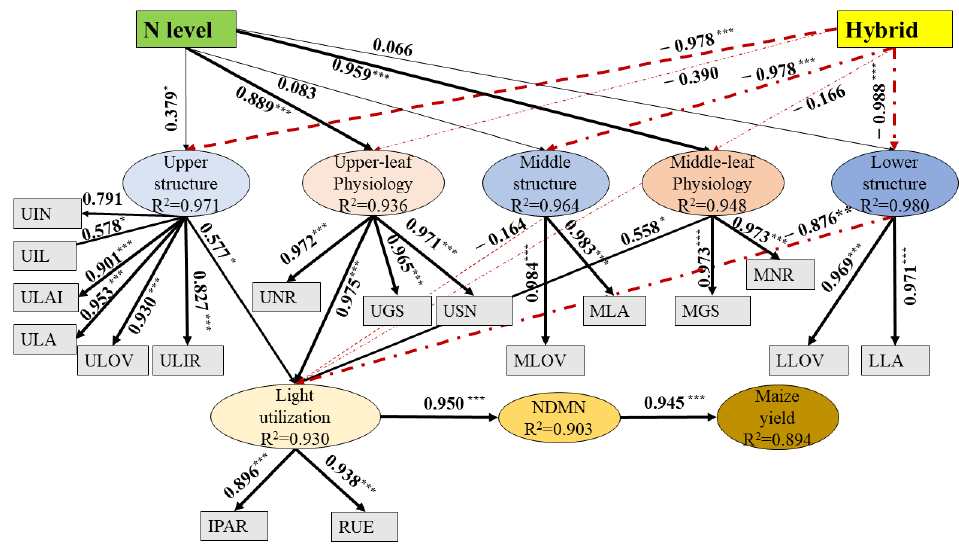
Figure 7. Structural equation models (SEMs) explaining the PNUE, RUE, NDMN, and maize grain yield in 2015. LLOV, leaf orientation value of the lower layer; LLA, lower - layer leaf angle. The other letters have the same meanings as in Figure 7. The number above each arrow is the standardized path coefficient. * p < 0.05, ** p < 0.01, *** p < 0.001. R 2 values within the circles denote the proportion of variance that can be explained by the corresponding variable in the SEM. The arrow width is proportional to the strength of the path coefficient adjacent to the numbers. Solid lines represent positive paths and dotted lines represent negative paths.